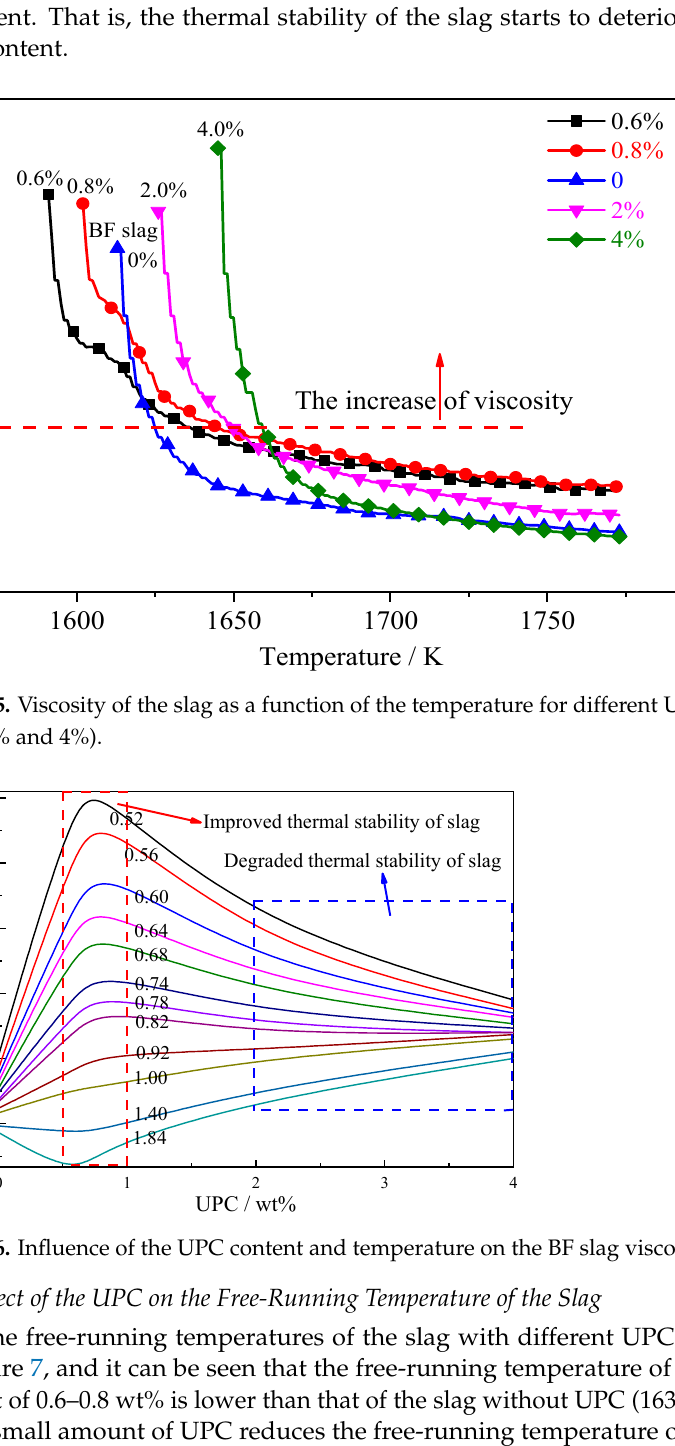
Figure 5. Viscosity of the slag as a function of the temperature for different UPC contents (0%, 0.6%, 0.8%, 2% and 4%).